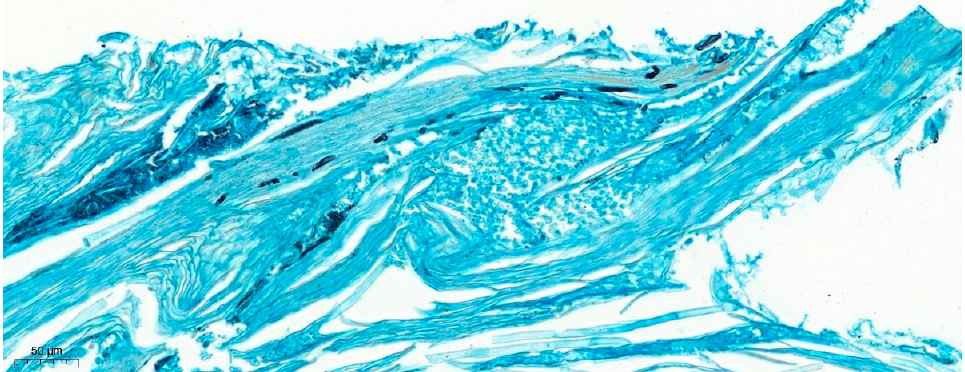
Figure 6. Nail clipping histopathology from the middle finger of a 25-year-old woman with single- digit onychomycosis. ( A ) Hematoxylin and eosin stain shows a basophilic fungal filament in the nail plate, ( B ) demonstrates the same area in PAS stain. Culture had grown Fusarium solani. Original magnification 200×.